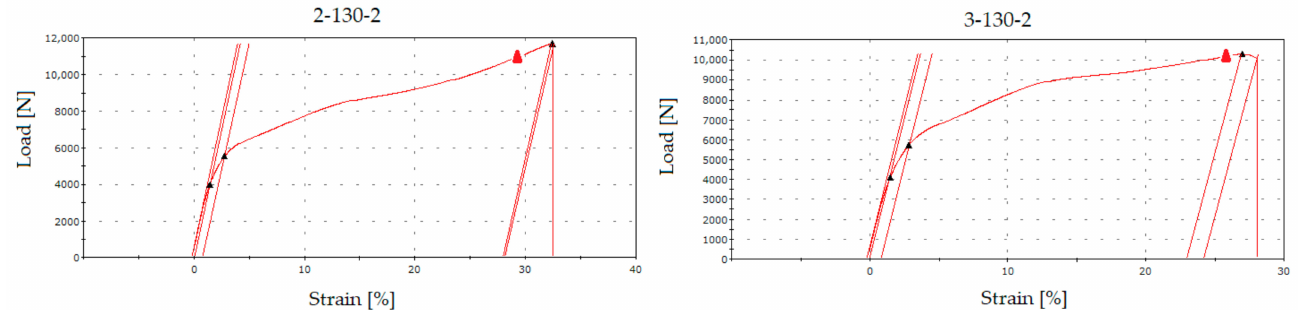
Figure 15. Tensile tests with samples “2-130-2” ( Left ) and “3-130-2” ( Right ) with indication of the point of interruption of transmission (red triangle) of the RFID tag.